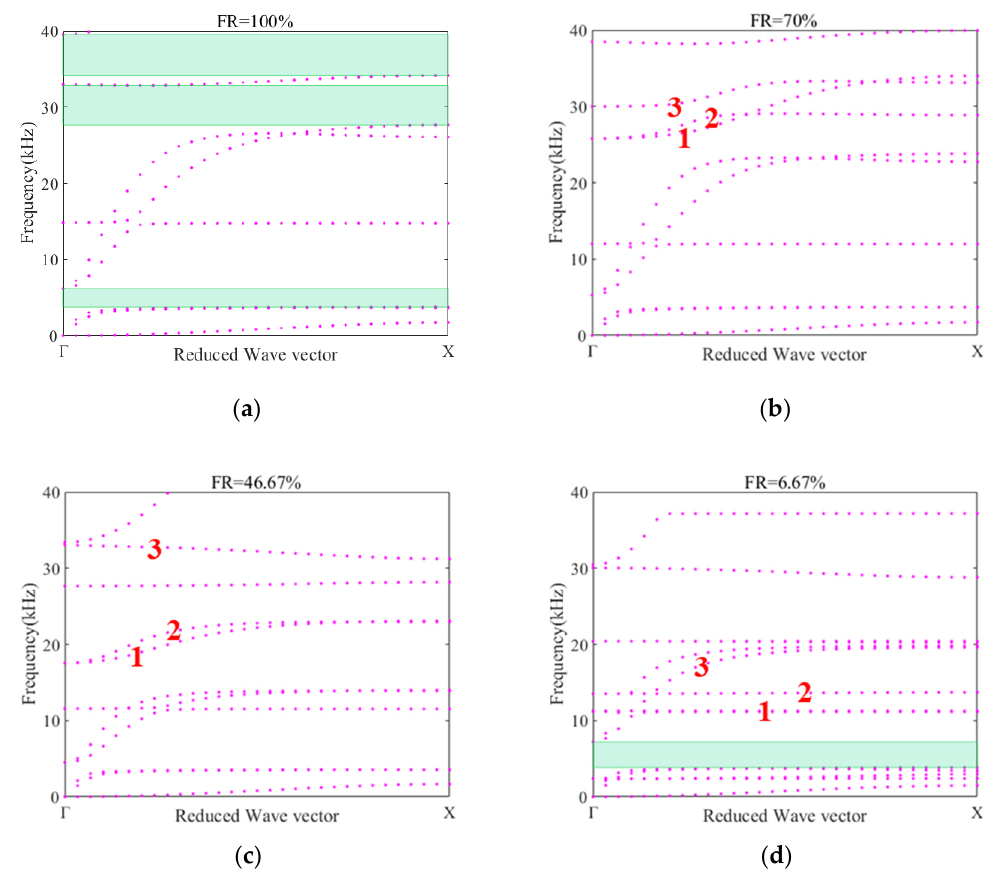
Figure 3. Dispersion curves of the double-pillar fillable structure along the boundary of the first irreducible Brillouin zone Г - х . ( a ) Dispersion curve when the FR = 100%; ( b ) dispersion curve when the FR = 70%; ( c ) dispersion curve when the FR = 46.67%; ( d ) dispersion curve when the FR = 6.67%.